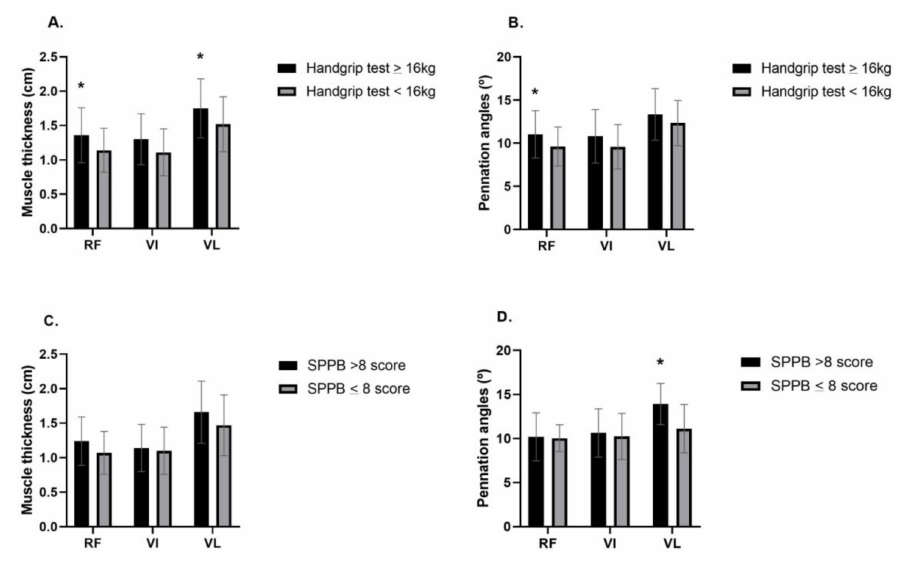
Figure 2. ( A , B ) Muscle thickness and pennation angle of patients according to the level of muscle strength assessed by handgrip test. ( C , D ) Muscle thickness and pennation angle of patients according to the level of physical performance assessed by SPPB. RF: rectus femoris; VI: vastus intermedius; VL: vastus lateralis; cm: centimeters; ◦ : degrees; kg: kilograms; SPPB: Short Physical Performance Battery; *: statistically significant difference ( p ≤ 0.05). Data presented as mean ± SD.